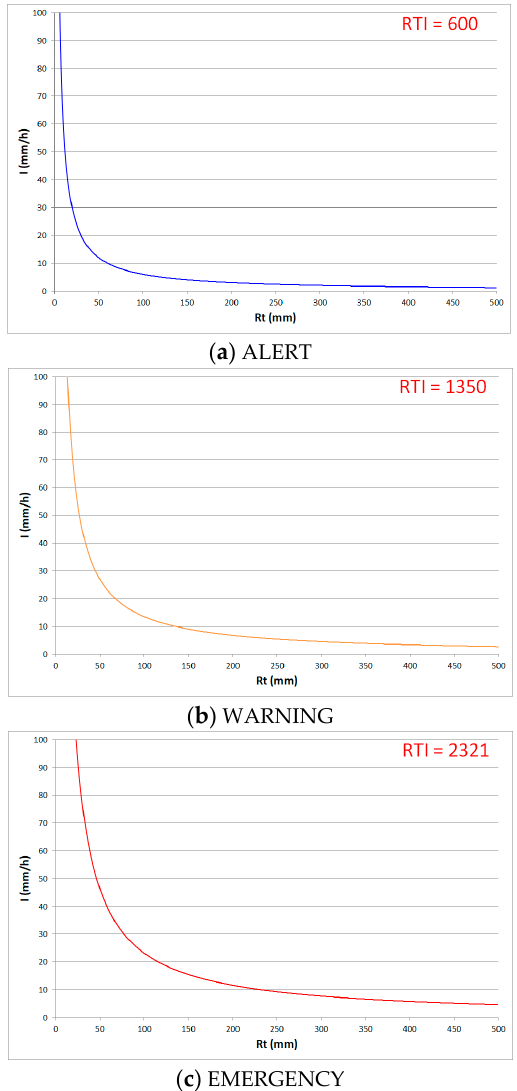
Figure 9. Estimation of rainfall triggering index (6 h): ( a ) ALERT; ( b ) WARNING; ( c )